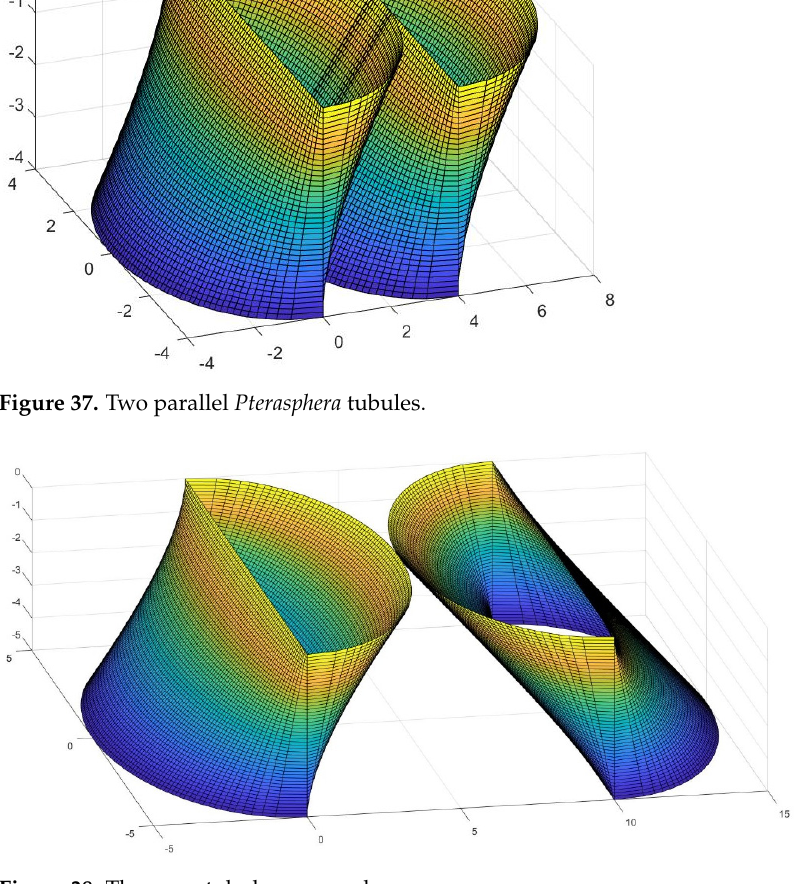
Figure 38. The same tubules opposed.